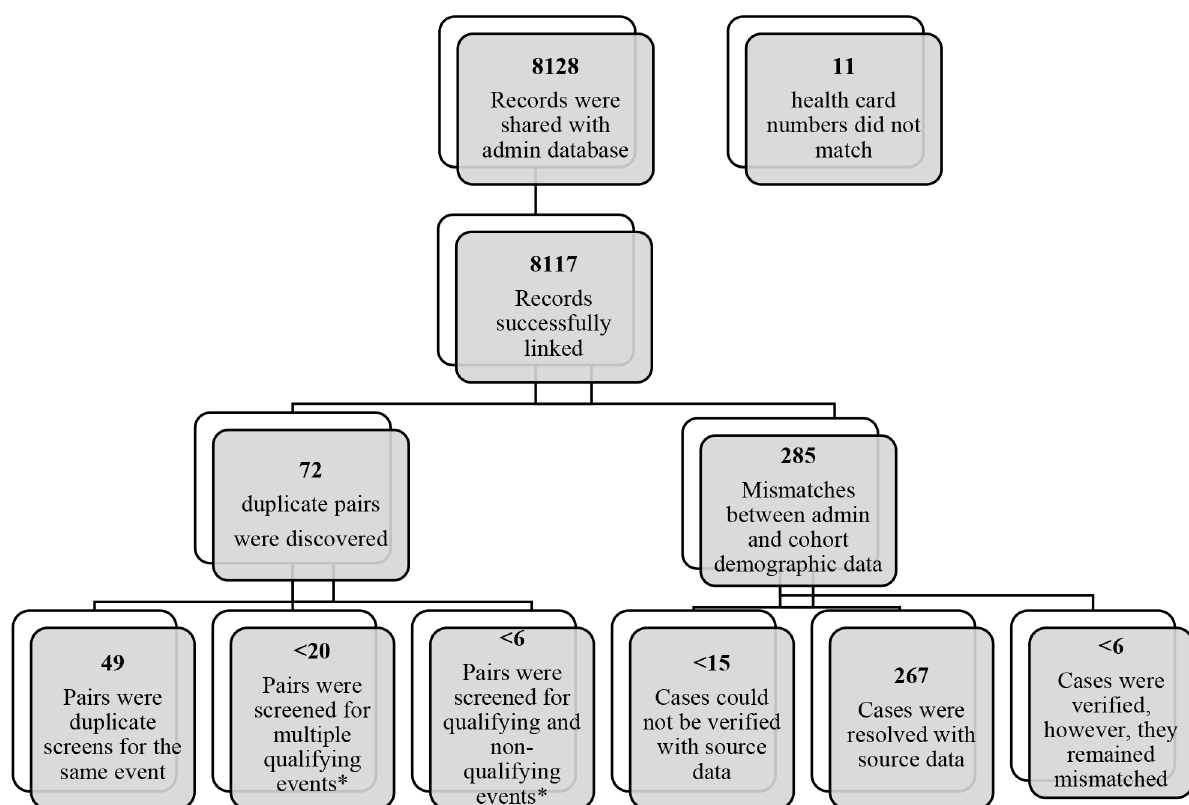
Figure 1: Results of the privacy-preserving record